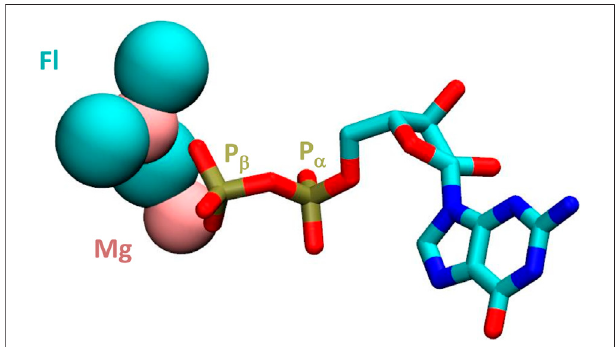
FIGURE 6 | Structure of GDP complexed with magnesium and fl uoride ions. The magnesium and fl uoride ions are shown in pink and turqouize, respectively in van der Waals representation. The remainder of the GDP molecule is shown as a liquorice model. The a and ß positions of the phosphorus atoms are highlighted. Based on coordinates from PDB#